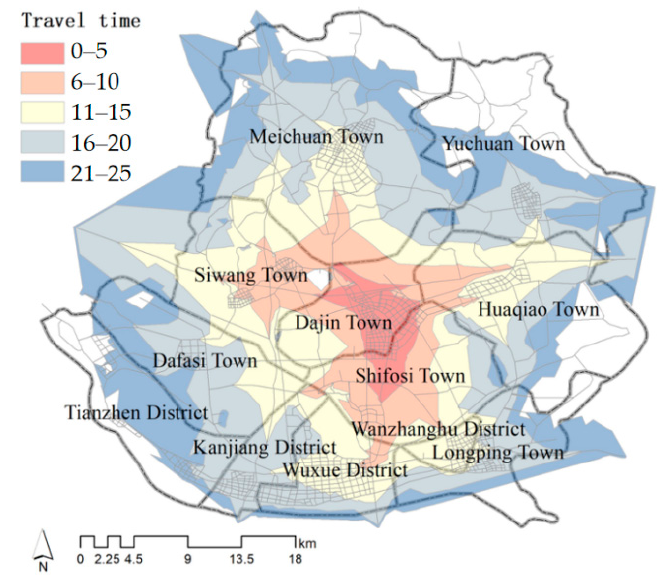
Figure 13. Accessibility analysis of railroad.